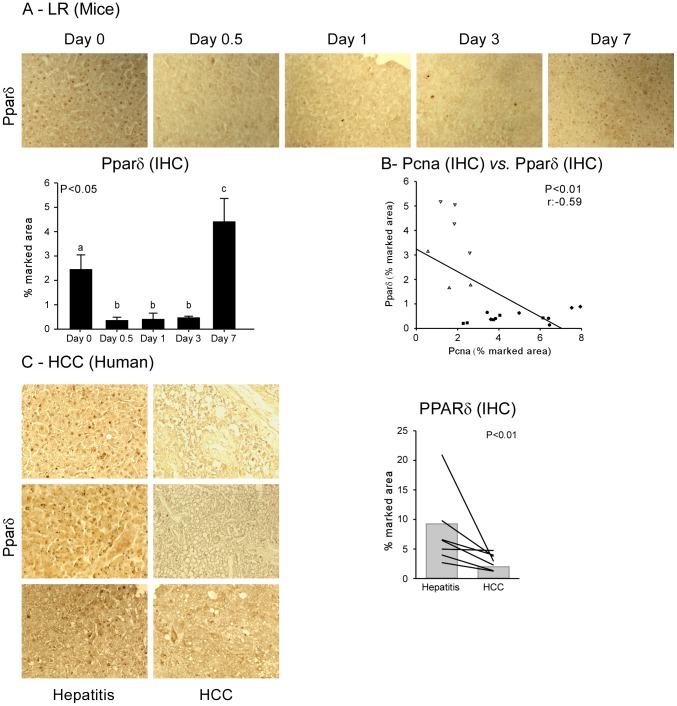
PPARβ/δ protein is suppressed in murine regenerating liver (A) and human HCC (C), and negatively correlates with PCNA (B).Anti-PPARβ/δ immunostaining in samples of LR (4–5/group) and 9 paraffin-embedded samples of HCC paired with reference tumor-free tissues (selection: 3 of 9 subjects); PPARβ/δ positive cells (percentage of marked area) were quantified using the ImageJ software. Results are shown as means ± SEM or means (bars) and cases (each line representing paired tumor-free tissue vs. tumor sample). Statistical significance (p≤0.05) assessed by the Kruskal-Wallis One-Way ANOVA on Ranks plus Nemenyi-Damico-Wolfe-Dunn post-hoc test (LR), Wilcoxon Signed-Rank Test (HCC), and Pearson's correlation coefficient (correlation). Legend: lower case letters indicate statistical significance (“a” means reference group; “b” means different from “a”; “c” means different from “a” and “b”); (white) quiescent; (black) proliferating; (▴) Sham; (▪) 0.5 days; (•) 1 day; (♦) 3 days; (▾) 7 days